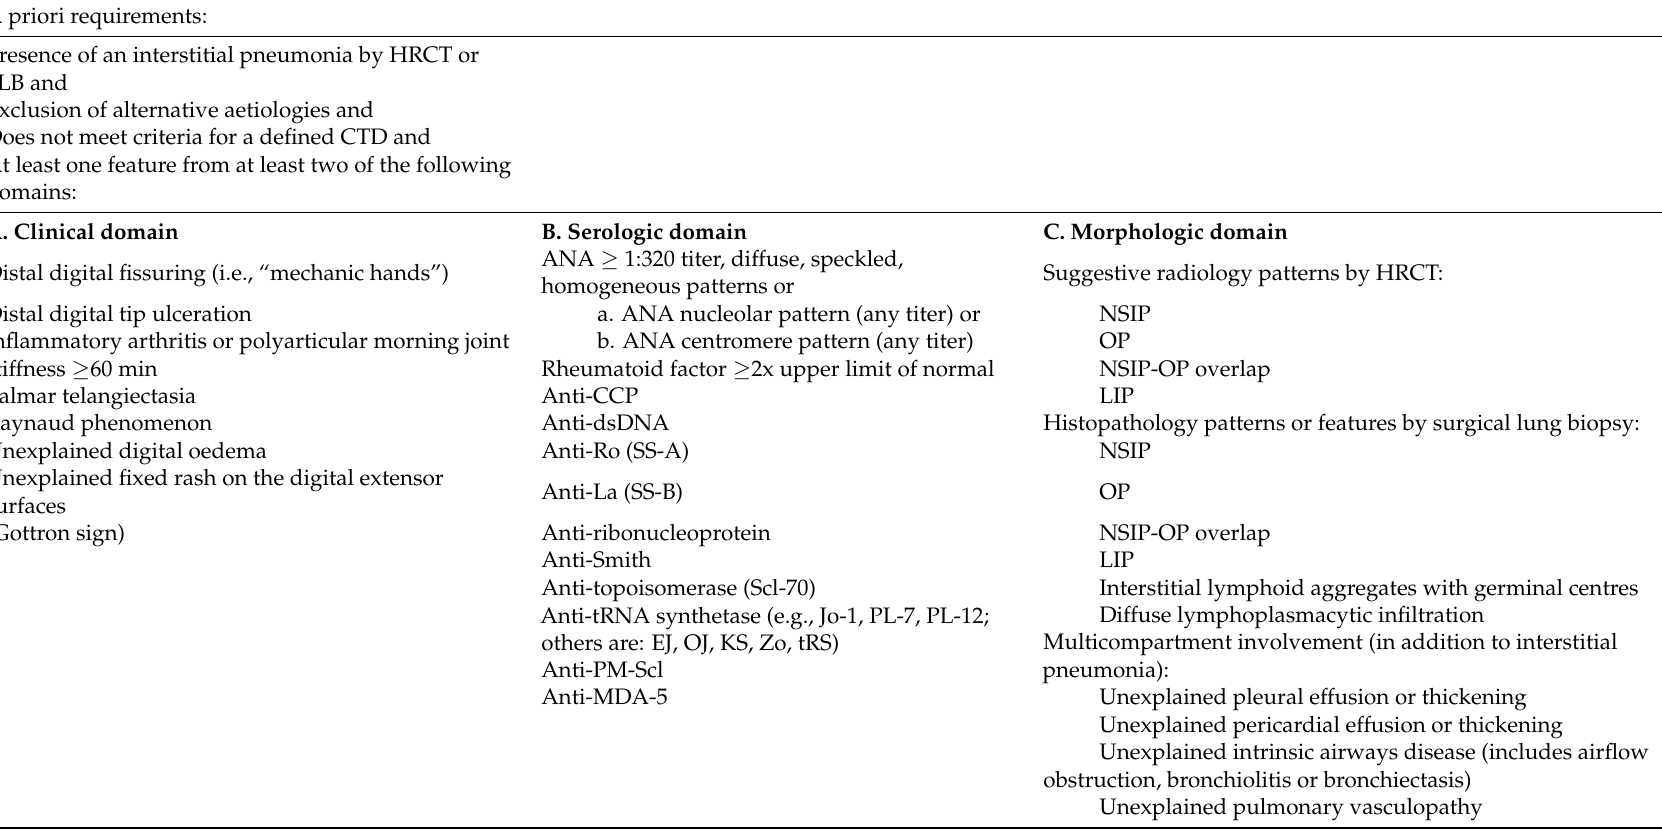
Table 1. Classification criteria for interstitial pneumonia with autoimmune